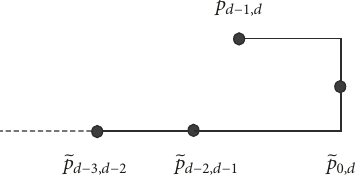
Figure 4: End point when 𝑛 0,𝑑 < 0 .